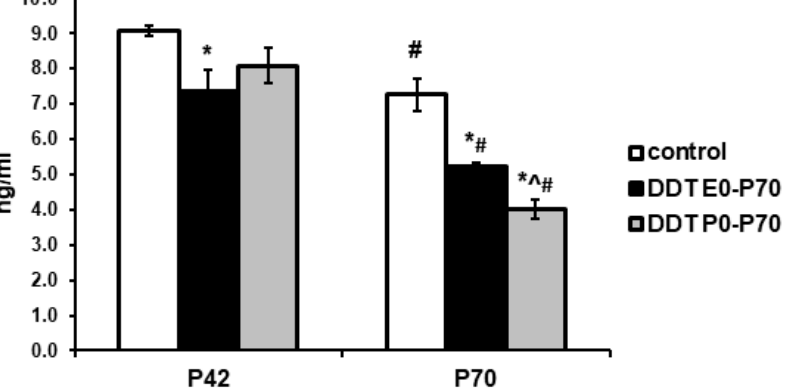
Figure 1. Epinephrine plasma concentration in the control and o,p-DDT exposed rats. Data are shown as mean ± S.E.M. P, day of postnatal development; p < 0.05 compared to the control (*), compared to the group DDT E0-P70 (^), compared to P42 (#).